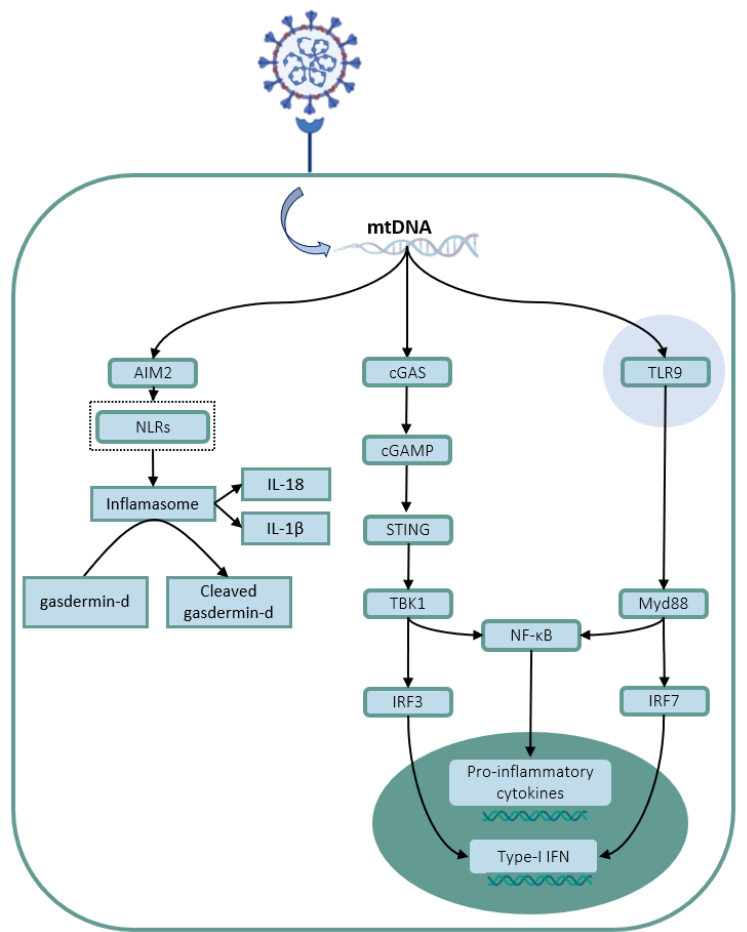
Figure 2. Molecular mechanisms involved in mtDNA recognition on the cytosol and endosome. SARS-CoV-2 infection leads to mtDNA releases. The TLR9, inside the endosome, recognizes mtDNA and triggers the Myd88 pathway, consequently inducing the release of pro-inflammatory factors and type-I IFNs, seen as well in cGAS pathway, but as a response of STING activation. The mtDNA is recognized by AIM2 leading to inflammasome activation, IL-18 and IL-1β production and cleave